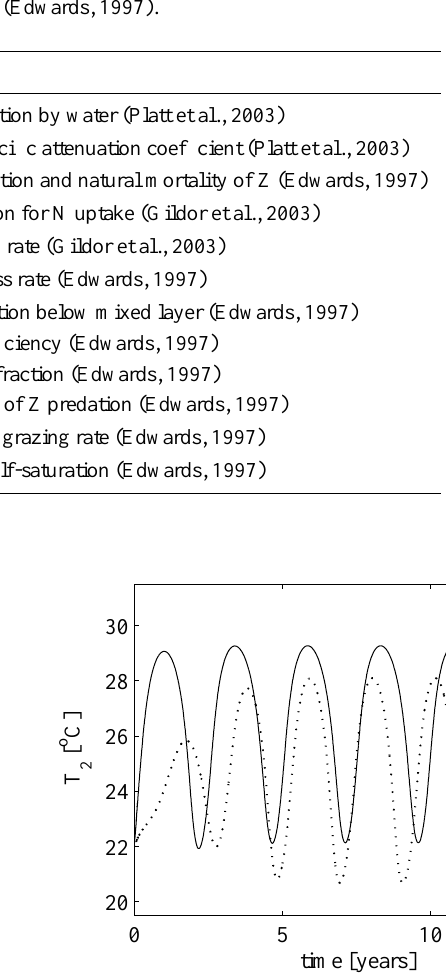
Table 2. Parameters relevant for the ecosystem model; for the parameter conversions, a carbon to chlorophyll ratio of 50mgC(mgchl) − 1 ,